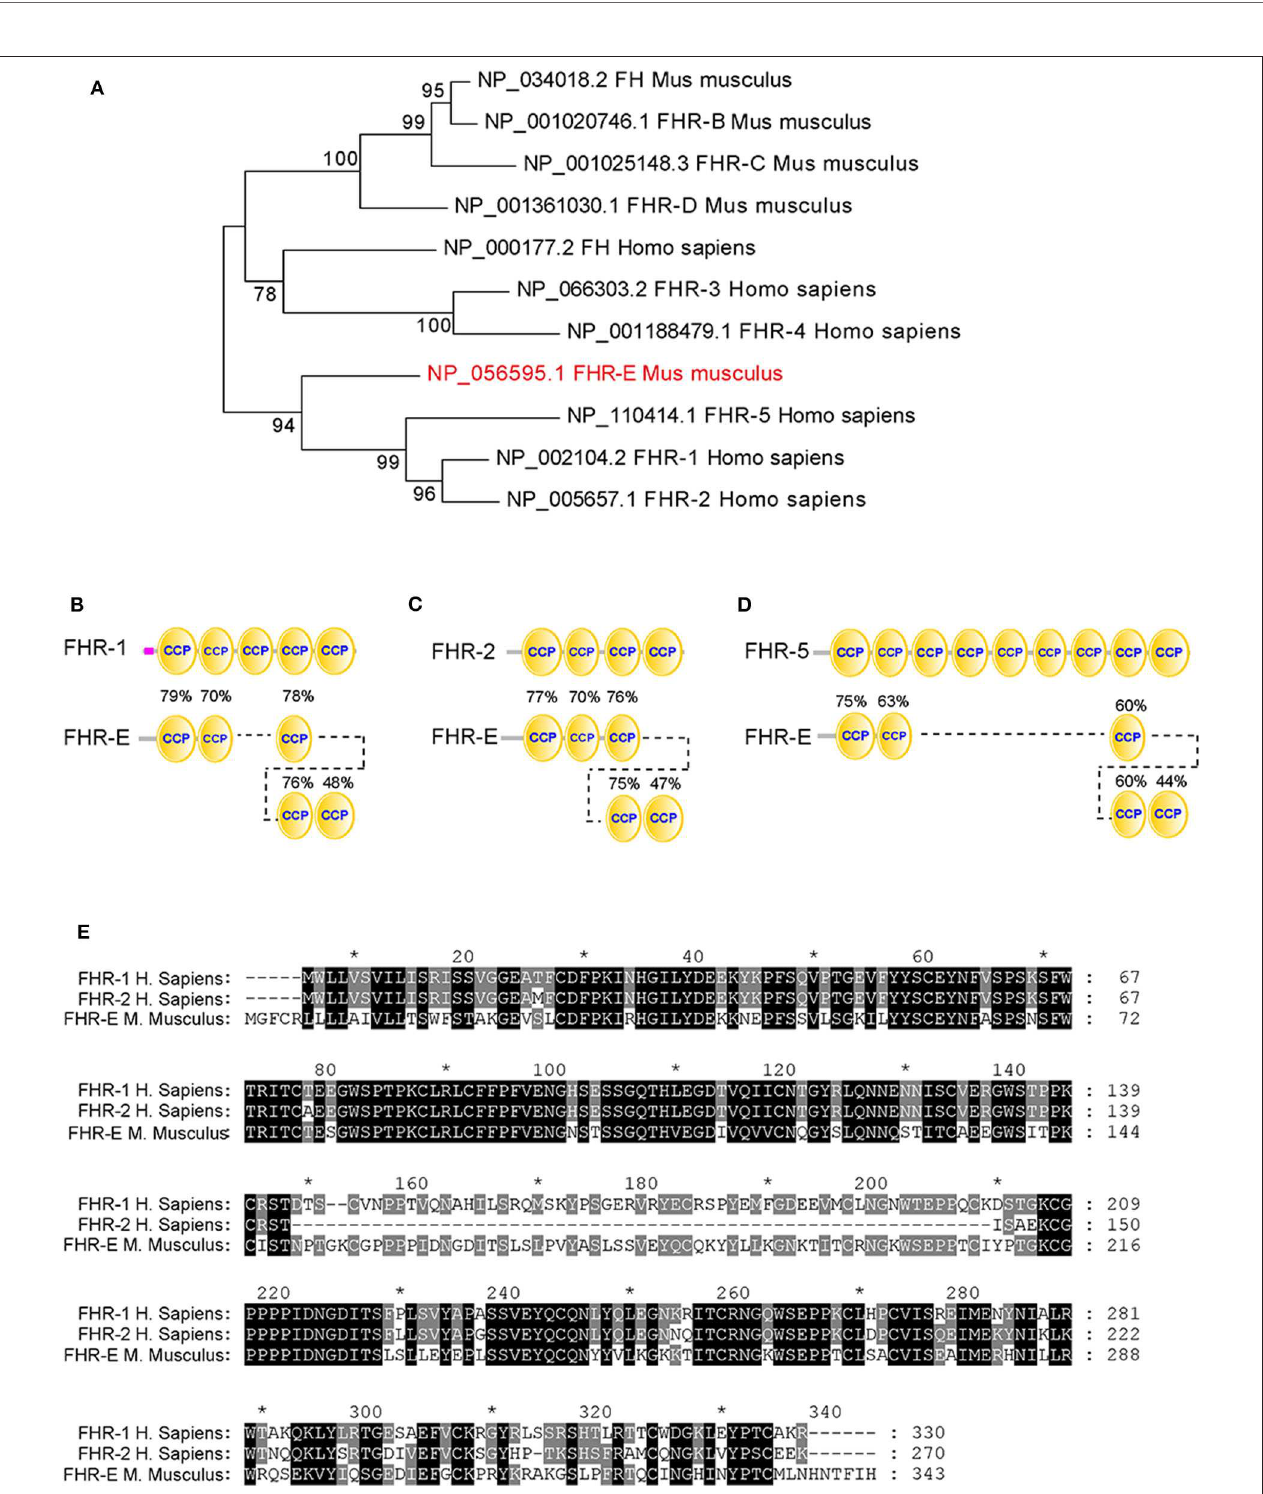
FIGURE 1 | Homology analysis of different FHRs between human and mouse. (A) The evolutionary tree of different FHRs in human and mouse. The percentage of replicate trees in which the associated taxa clustered together in the bootstrap test (1,000 replicates) were shown next to the branches. (B–D) The similarity analyses between FHR-E and human FHR-1, FHR-2, and FHR-5. The percentages marked on these figures denote the similarities between the CCP domains of FHR-E and human FHR-1, FHR-2, and FHR-5. (E) The sequence alignment of FHR-E and human FHR-1 and FHR-2. * Indicates the number of amino acid. It was marked every twenty amino